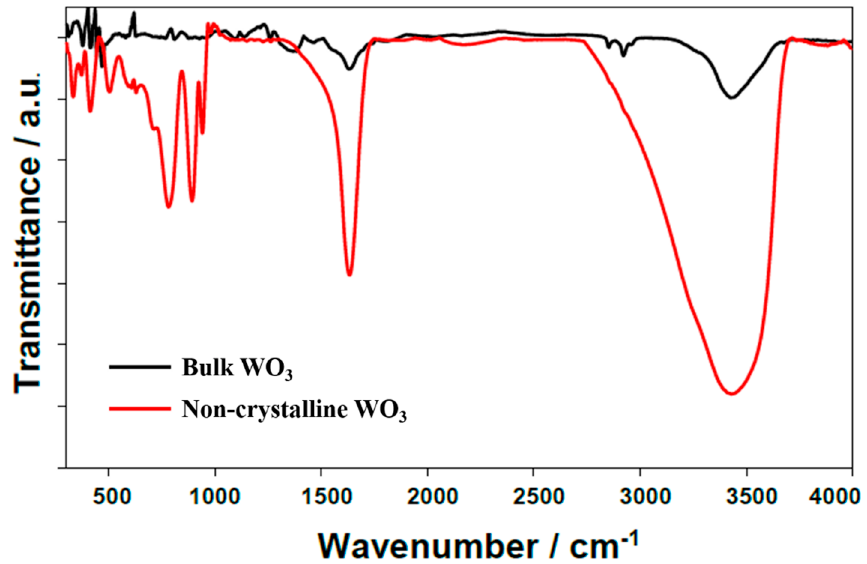
Figure 4. FTIR spectra of bulk and hydrated and non-crystalline WO 3 .